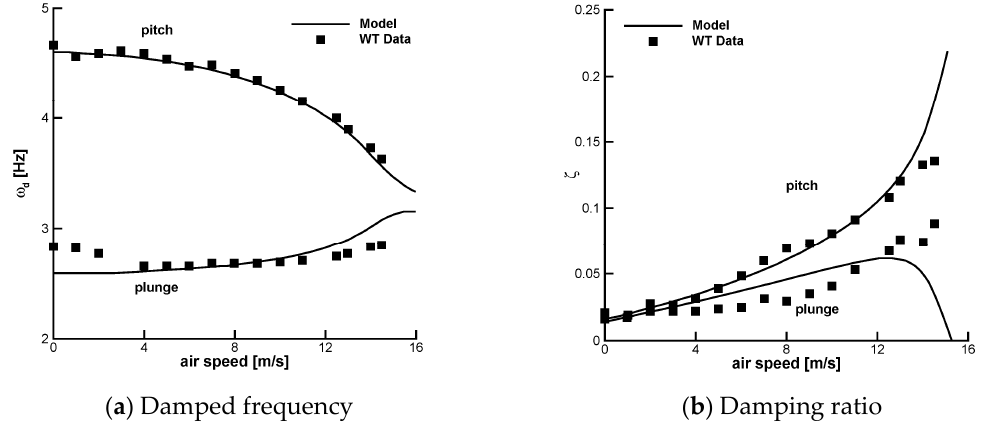
Figure 5. Dependency of damped frequency, ω d and damping ratio, ζ , with freestream speed; aeroelastic parameters from Table 1 ( b = 0.175 m and ω α = 28.061 rad/s); flutter speed predicted 15.28 m/s.